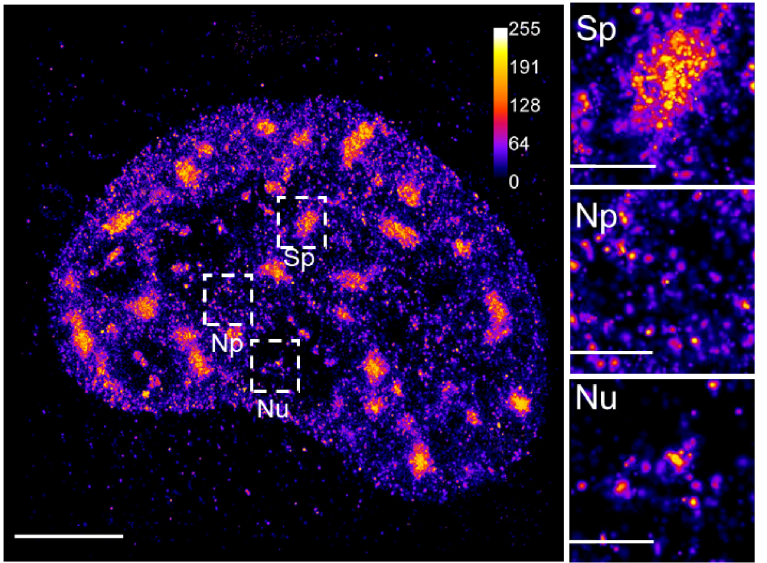
Figure 3. 3D dSTORM imaging of nuclear phosphatidylinositol 4,5-bisphosphate. A 2D projection of the 3D dSTORM image of the nuclear phosphatidylinositol 4,5-bisphosphate (PIP2) indirectly immunolabeled by primary anti-PIP2 antibody followed by secondary antibody conjugated with Alexa Fluor 647 and imaged by 3D dSTORM. Selected regions show specific pattern of PIP2 associated with nuclear speckles (Sp), nucleoplasm (Np) and nucleolus (Nu). Calibration bar shows relative fluorescence intensities. Scale bar = 5 µm; inset 1 µm.